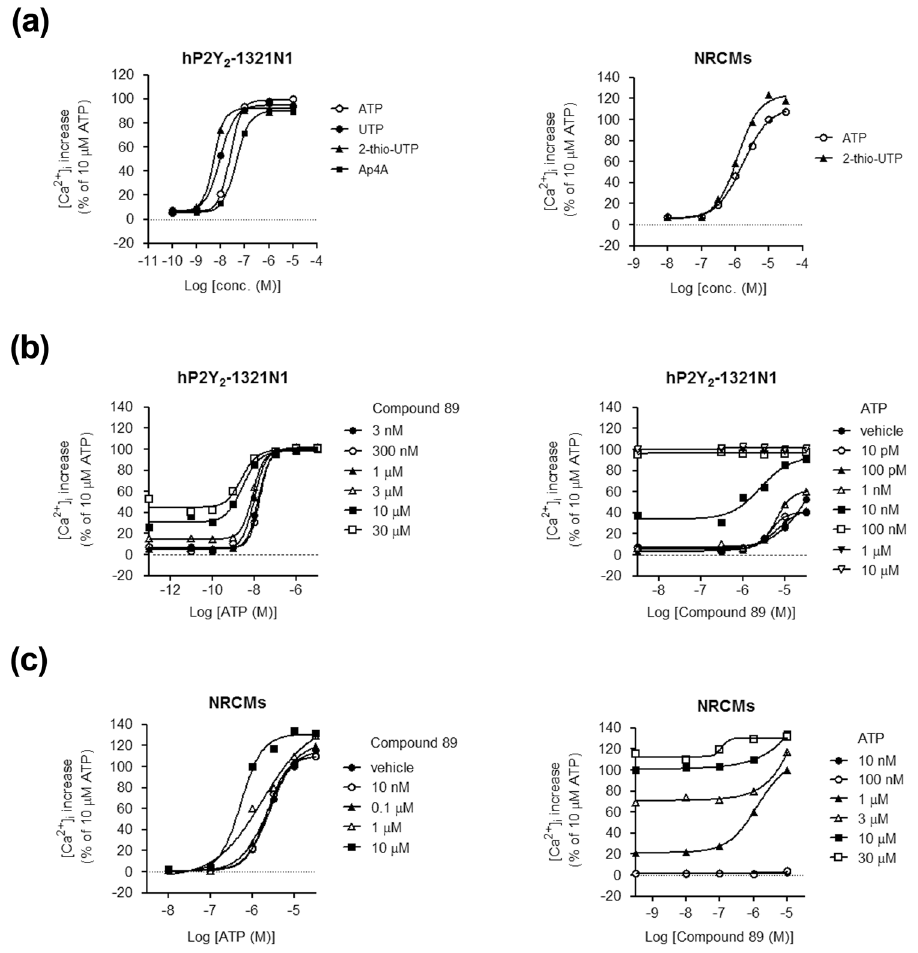
Figure 2. Compound 89 exhibits allosteric modulatory effects on ATP-induced Ca 2 + mobilization in P2Y 2 - overexpressing 1321N1 cells and in cardiomyocytes. ( a ) Concentration-response curves of physiological agonists in a FLIPR Ca 2 + mobilization assay using hP2Y 2 stably-expressing 1321N1 cells and NRCMs. ( b ) Allosteric modulatory effect of Compound 89 on the ATP concentration-response curve ( left ), and allosteric modulatory effect of ATP on the Compound 89 concentration-response curve ( right ) in hP2Y 2 stably- expressing 1321N1 cells. ( c ) Allosteric modulatory effect of Compound 89 on the ATP concentration-response curve ( left ), and the allosteric modulatory effect of ATP on the Compound 89 concentration-response curve ( right ) in NRCMs. The activity of 10 μ M ATP was normalized to 100%. All data points represent the mean of experiments performed in duplicate or triplicate, and comparable results were obtained by another independent